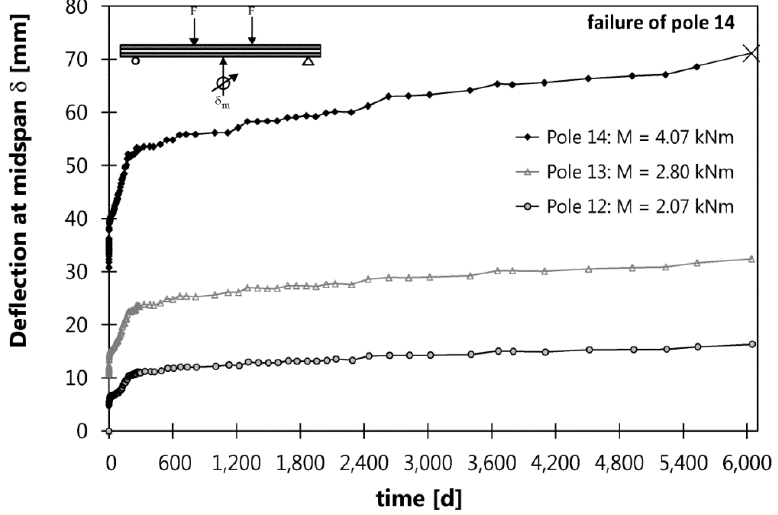
Figure 5. Bending creep tests of pole Nos. 12–14: creep deflection at midspan vs.